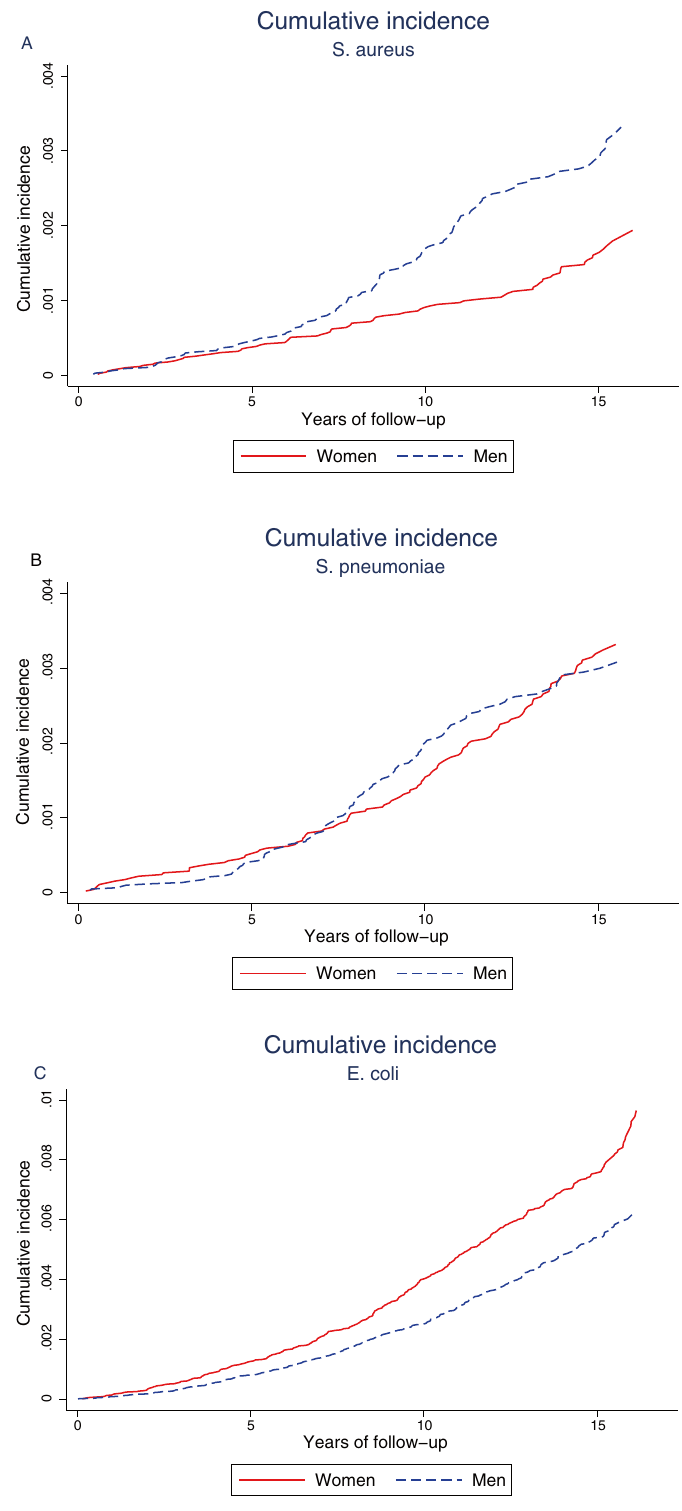
Figure 3. Sex differences in cumulative incidence of BSI caused by the most common bacteria. Age-adjusted sex difference in cumulative incidence of S. aureus ( A ), S. pneumoniae ( B ), and E. coli ( C ), estimated for age 49.99 (the mean age of the total population). Note: due to the variation in incidence of different bacteria the scale of the Y-axis is not uniform across the